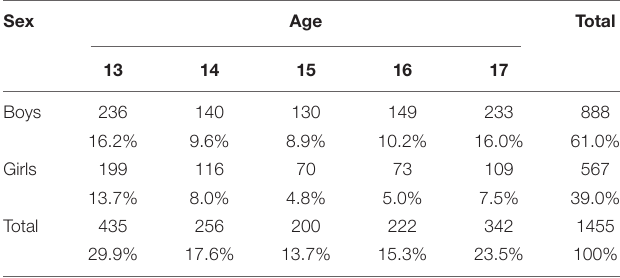
TABLE 1 | Sample distribution across sex and